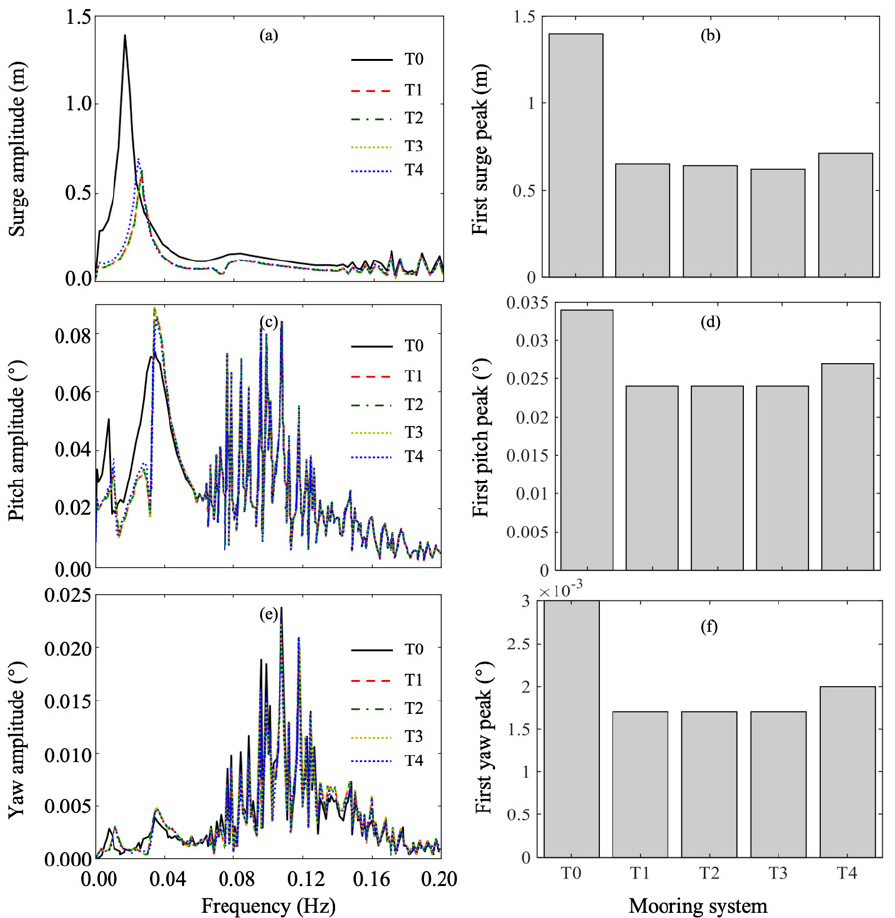
Figure 14. Frequency − amplitude curve and first peak amplitude in C5: ( a ) and ( b ) surge; ( c ) and ( d ) pitch; ( e ) and ( f ) yaw.